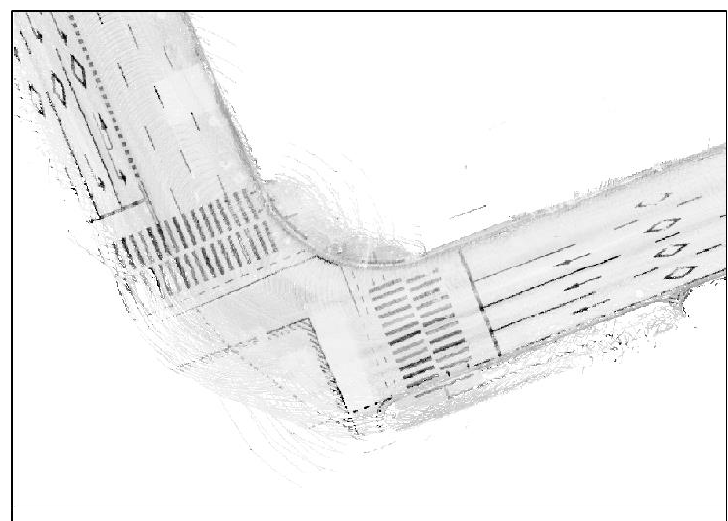
Figure 7. Generated road reflectivity map (after plane extraction).